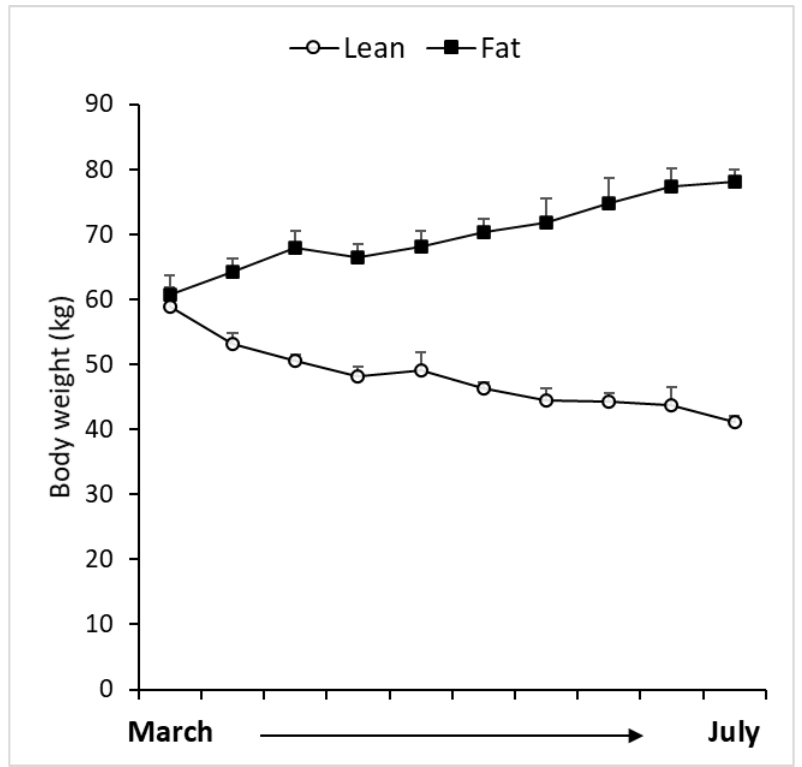
Figure 1. Temporal changes in body weight in lean and fat animals; which were maintained until July (time of experiment).